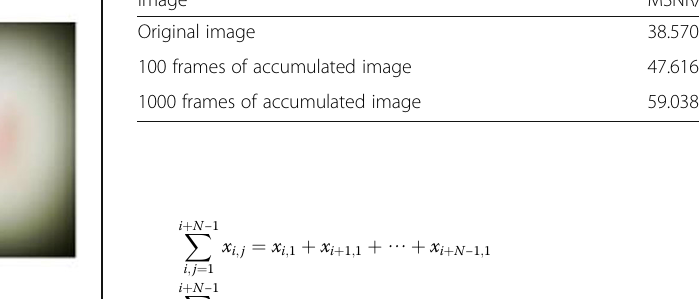
Fig. 3 The schematic of image cropping